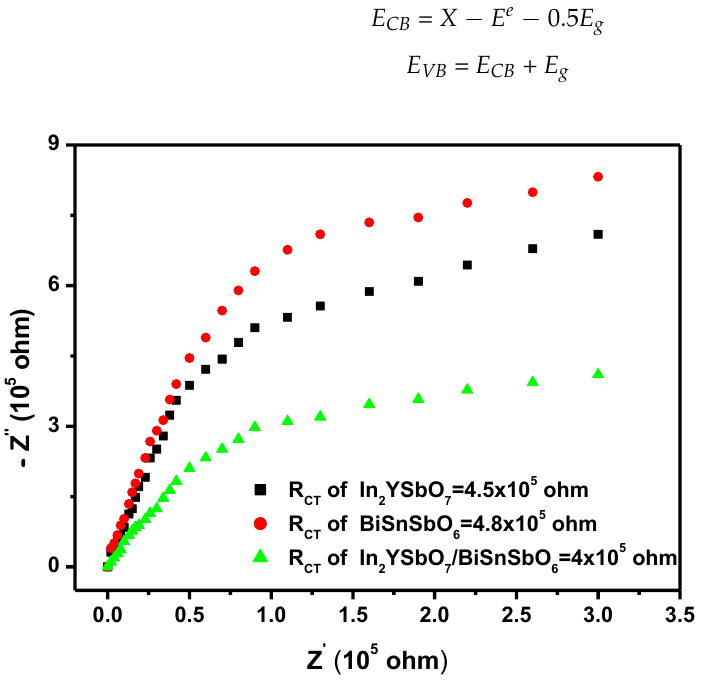
Figure 23. Nyquist impedance plots of IBHP or In 2 YSbO 7 photocatalyst or BiSnSbO 6 photocatalyst.